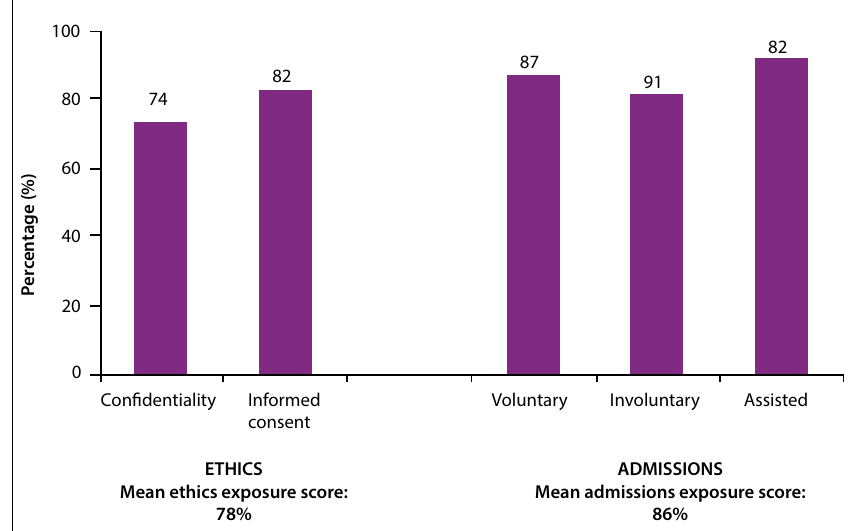
Fig. 3. Exposure to preparatory psychiatric activities.